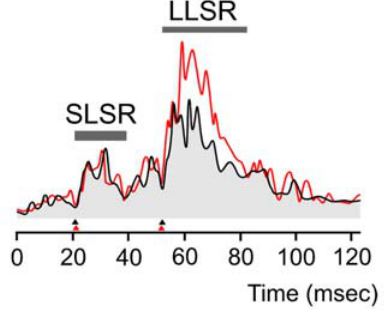
Figure 7. Representative EMG activities for the flexor carpi radialis muscle (FCR) during rapid stretches of the wrist (extensions) in a control subject (black trace) and a cerebellar patient (red trace). The intensities of the short-latency stretch response (SLSR) are similar. The intensity of the long-latency stretch response (LLSR) is higher in the patient. Each trace corresponds to an average of 45 trials. Stretch responses are calibrated in arbitrary units. Arrowheads at the bottom of the traces indicate the onset latencies of SLSR and LLSR.